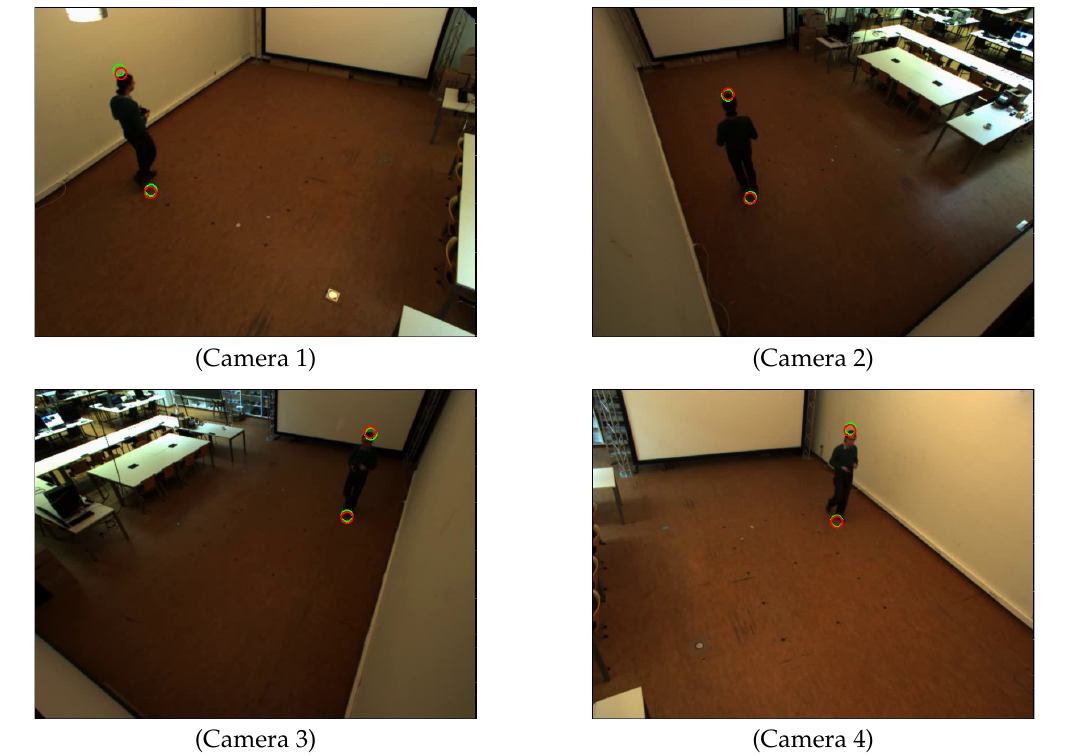
Figure 4. Detected feet and head positions for each camera. Green circles represent detected positions using ellipse fitting. Red circles represent detected positions using bounding box fitting and line